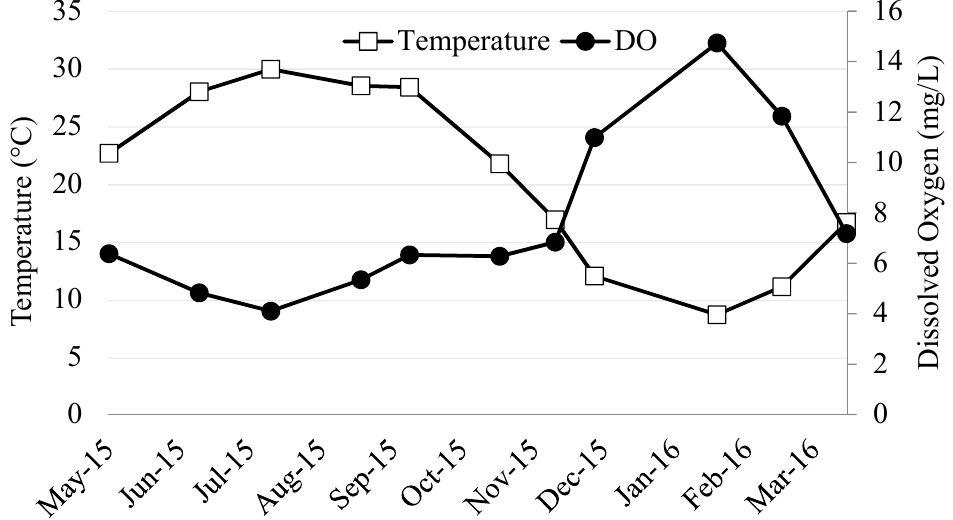
Figure 3. Average temperature and dissolved oxygen concentration fluctuations in the Atchafalaya River (AR) from May 2015 to May 2016.